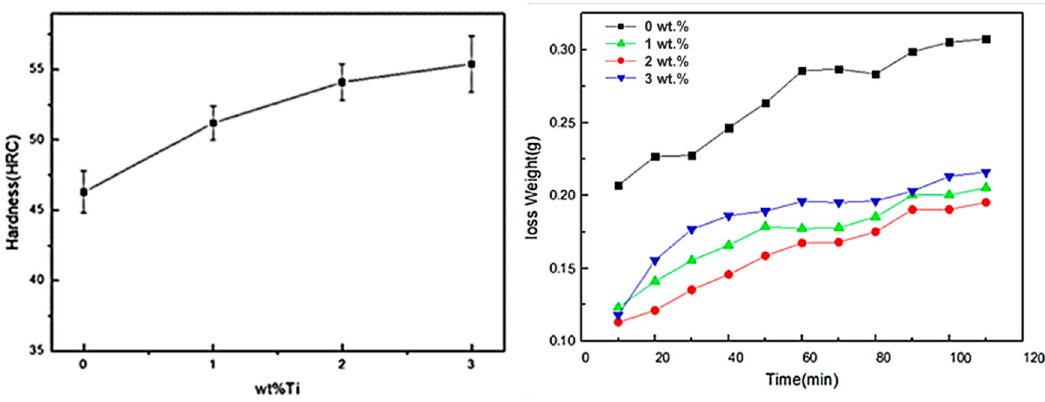
Figure 4. Hardness and wear curves of the white cast iron with different experimental conditions.